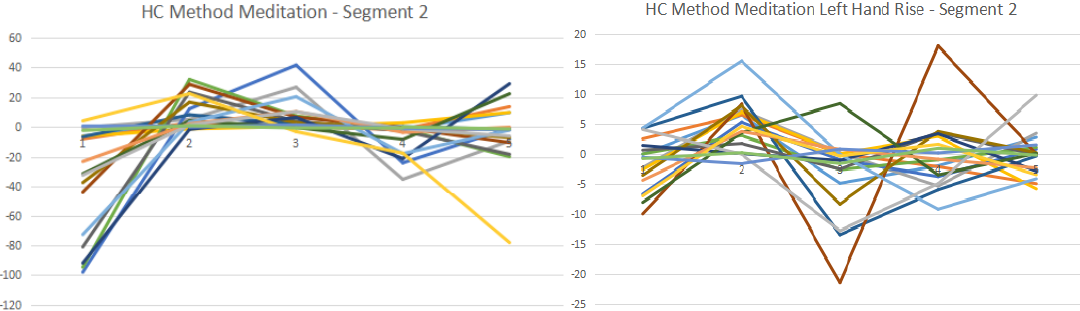
Figure 8 . EEG clustering results based on two statuses ( meditation, left - hand rise mediation; results Figure 8. EEG clustering results based on two statuses (meditation, left-hand rise mediation; results from 5 clusters, PDA segment 2 ). from 5 clusters, PDA segment